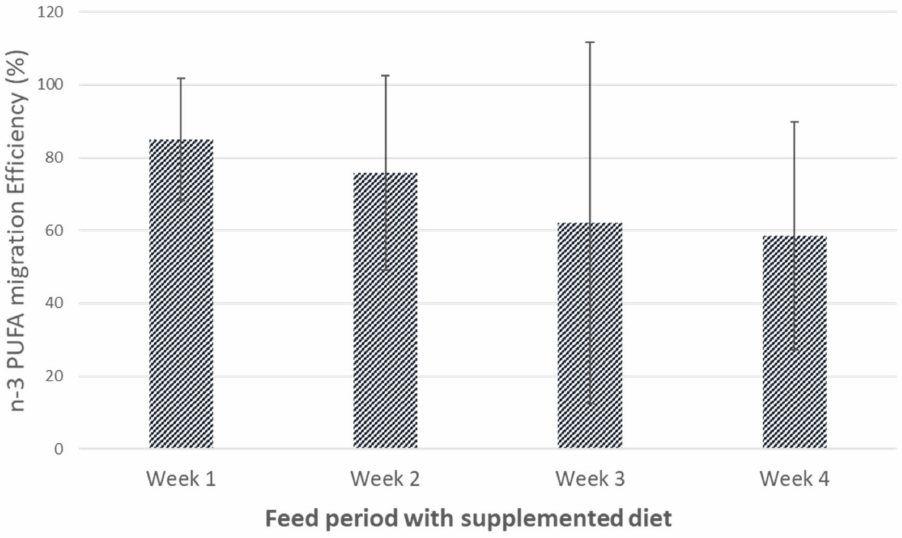
Figure 2. Efficiency of n-3 polyunsaturated fatty acid (PUFA) migration from Nannochloropsis oceanica supplemented feed to hen eggs, along the feeding